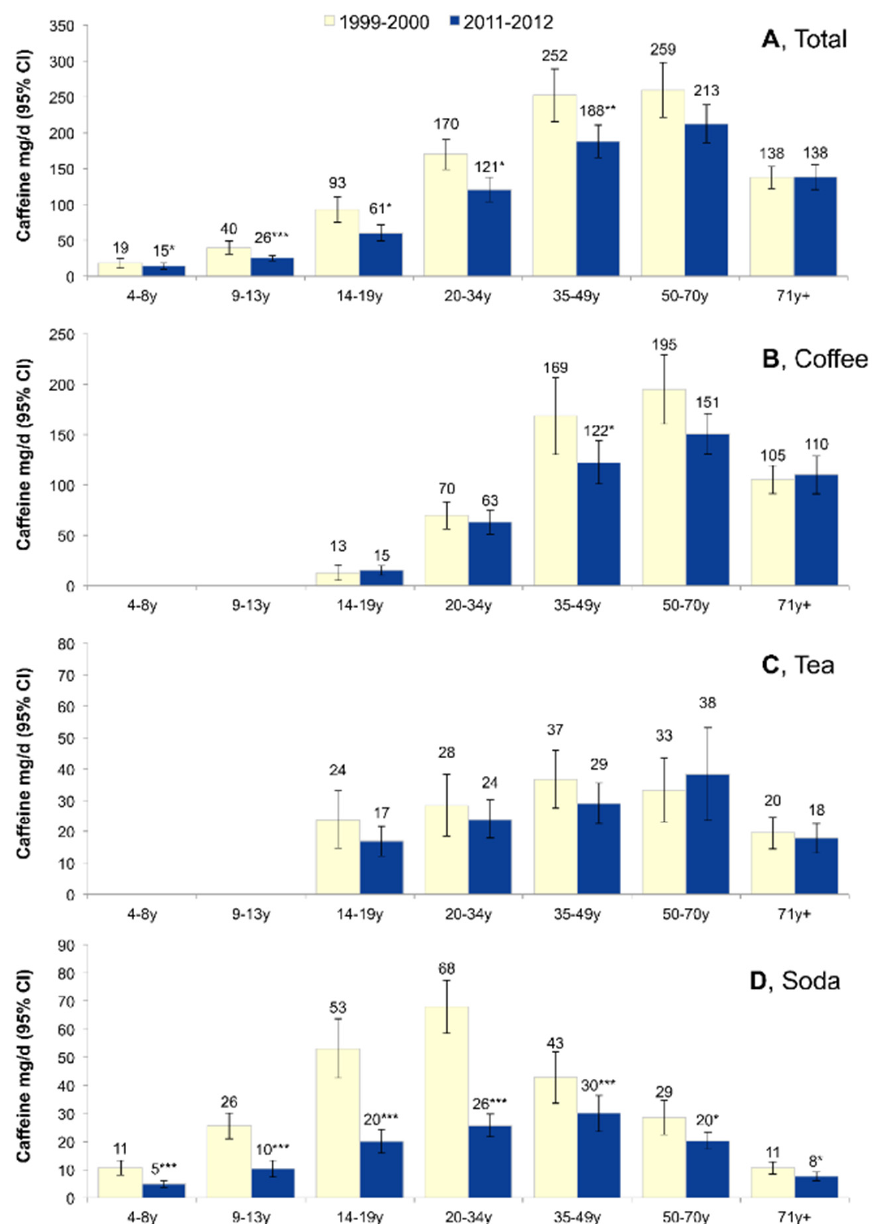
Figure 3. Trends in caffeine consumption stratified by age group and beverage type. Data are for NHANES 1999–2000 and for NHANES 2011–2012. Data are for ( A ) total caffeine; ( B ) Coffee; ( C ) Tea; ( D ) Soda. The p -interaction for the age by year interaction was p = 0.016, p = 0.12, p = 0.58, and p < 0.001 for total caffeine, coffee, tea, and soda, respectively. Error bars are 95% confidence